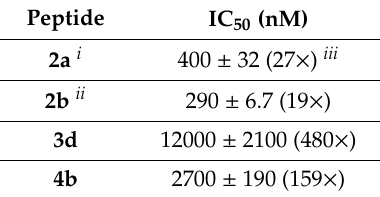
Table 2. PBD-binding a ffi nities of peptides against full-length Plk1 using an ELISA